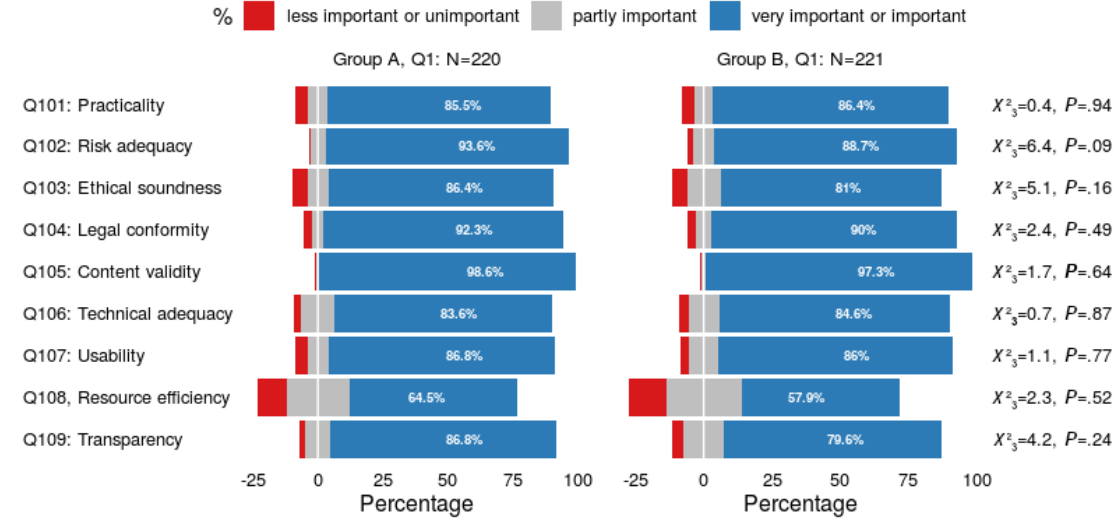
Figure 2. Participants’assessments, stratified by group, of the perceived importance of the nine quality principles, including corresponding results for the chi-square tests that only show statistically insignificant differences between groups. Q1: questionnaire 1.